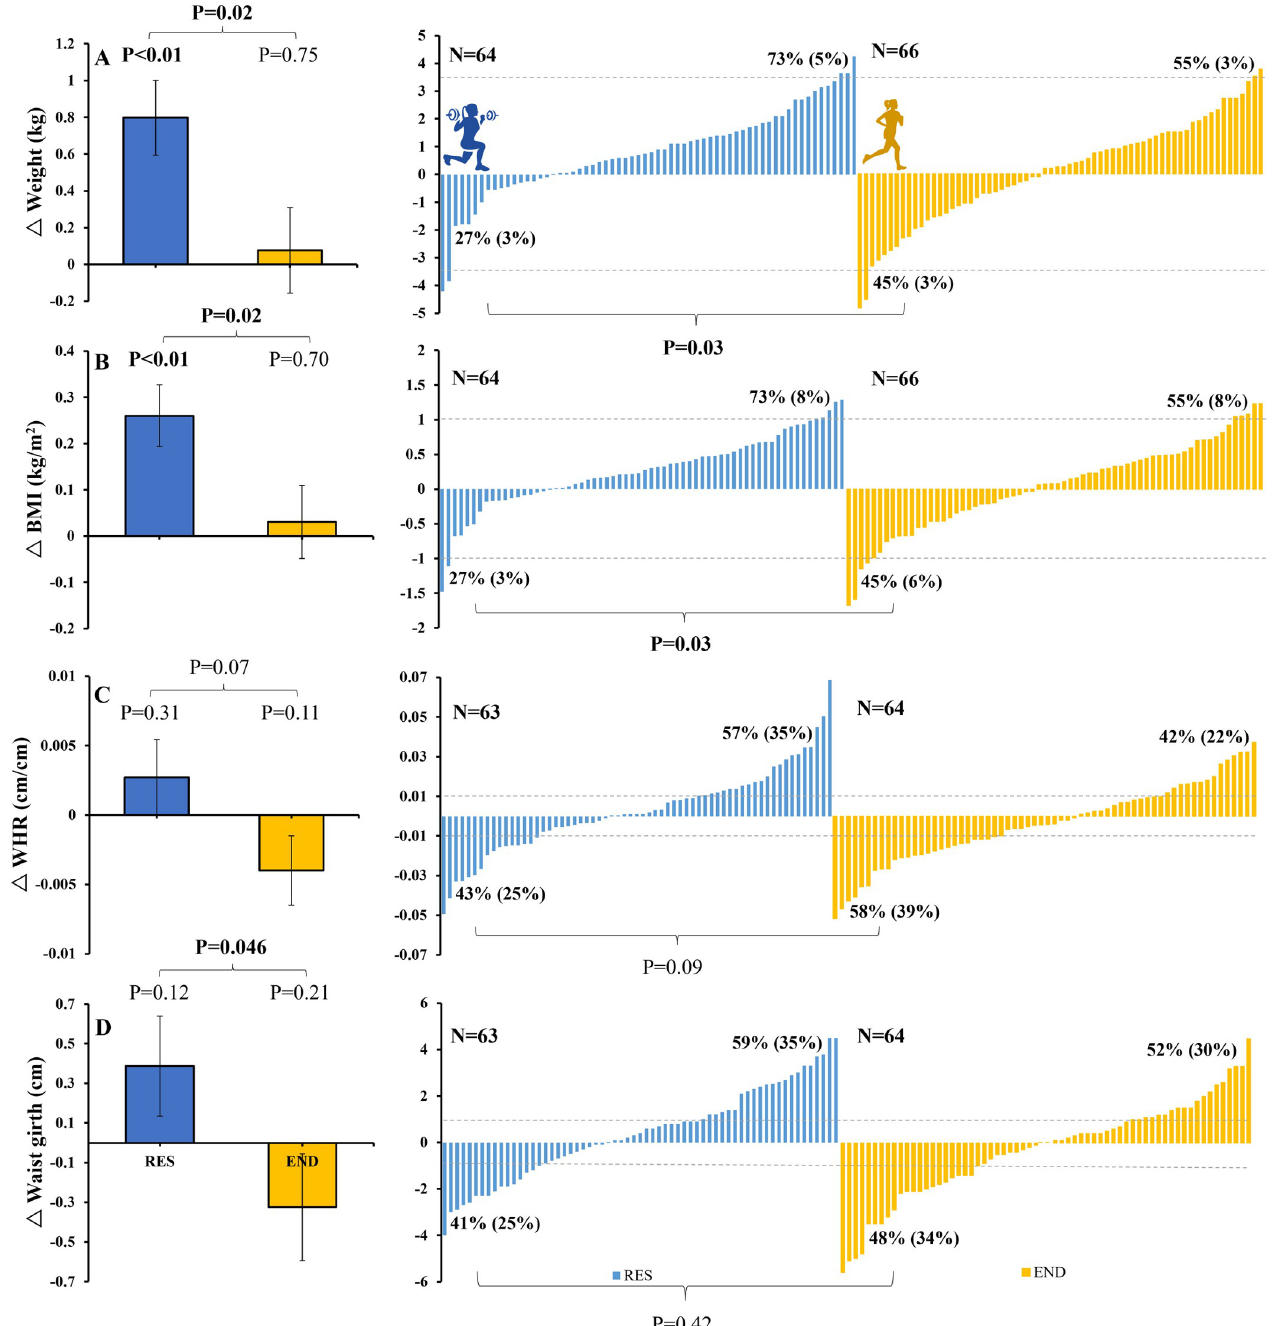
Fig 2. Changes ( Δ ) with RES (blue) and END (yellow) training for body weight (top panel, A), BMI (panel B), WHR (panel C), and waist girth (panel D) for group (left) and individual responses to RES (middle) and END (right) training. Dotted lines represent previously reported clinically meaningful changes. A 5% decrease in weight (equating to 3.5 kg for our study participants) has been considered to be clinically meaningful [21, 22]. A 1 kg/m 2 increase in BMI was associated with a 5% (M) and 7% (F) increased risk of heart failure and a 4–6% increased risk of stroke [27]. A 0.01 unit increase in WHR was associated with a 5% increased risk of future CV disease [28]. A 1cm increase in waist girth was associated with a 2% increased risk of future CV disease [28]. Proportions (%) are indicated for responders (any positive change) and non-responders (negative response or no change). Numbers in parentheses reflect responses equal to or beyond the level of clinically meaningful change, as indicated by the dotted